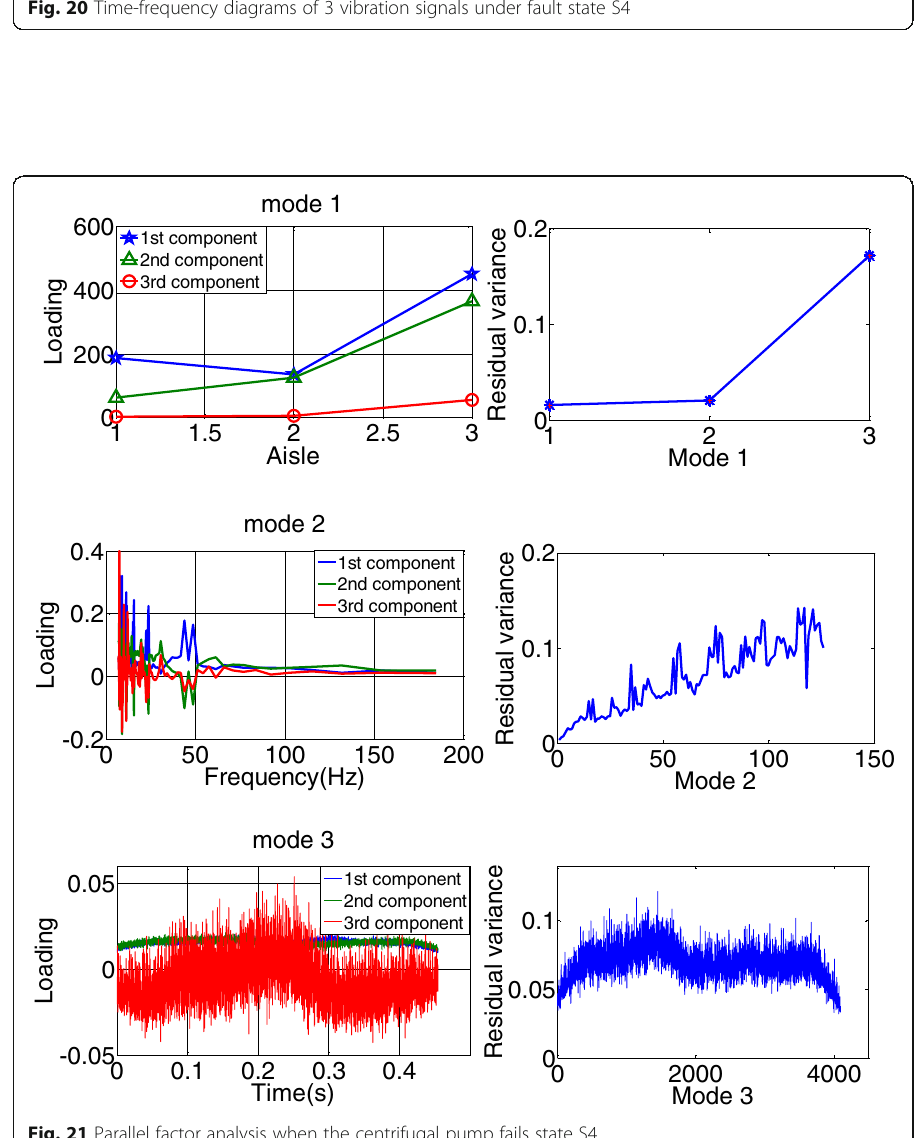
Fig. 21 Parallel factor analysis when the centrifugal pump fails state